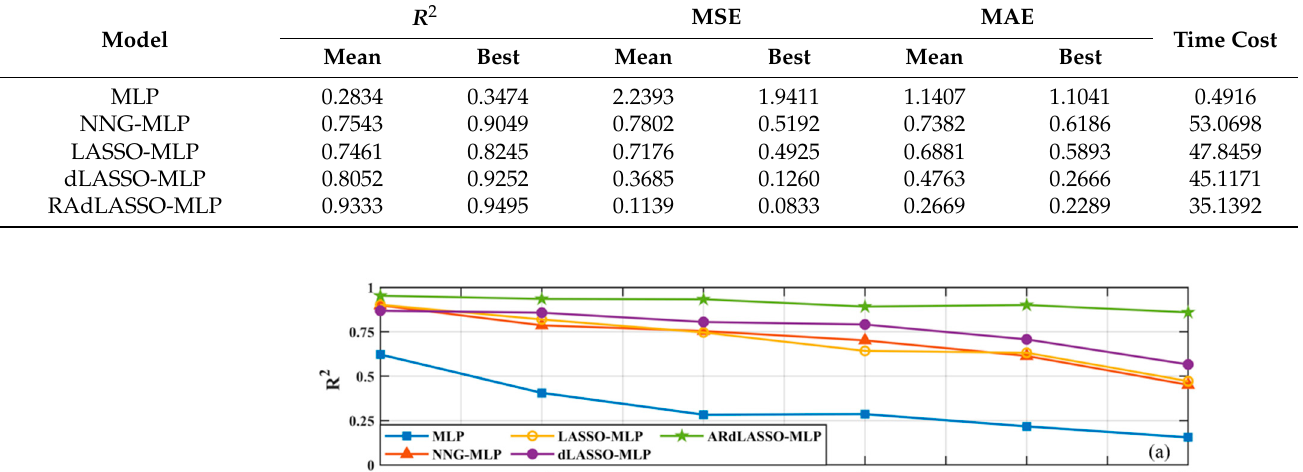
Table 4. Comparison results of different algorithms for contaminated data ( η = 0.3).